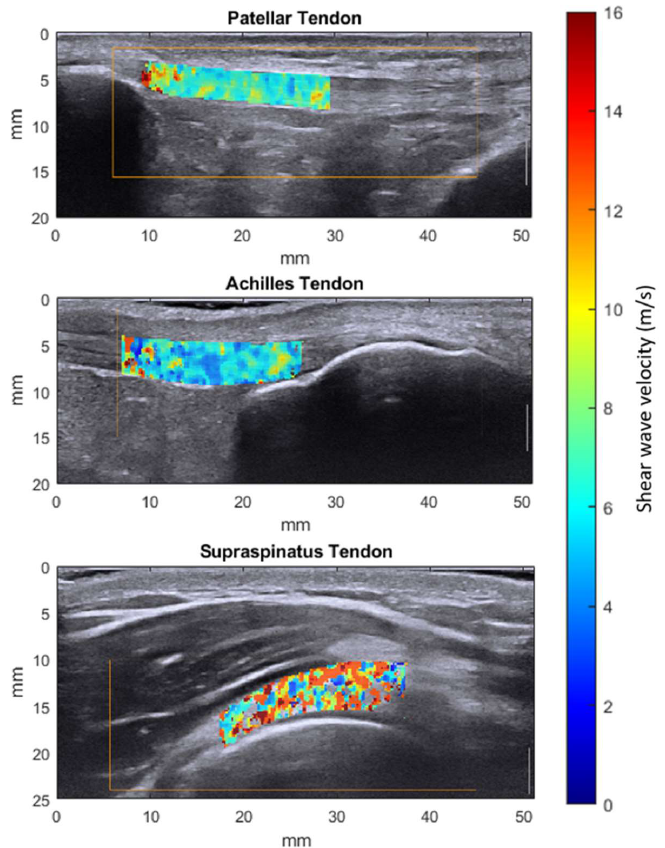
Figure 2. Exemplary 2D shear wave elastography measurements of the 3 types of tendons studied after the manual segmentation of the region of interest.